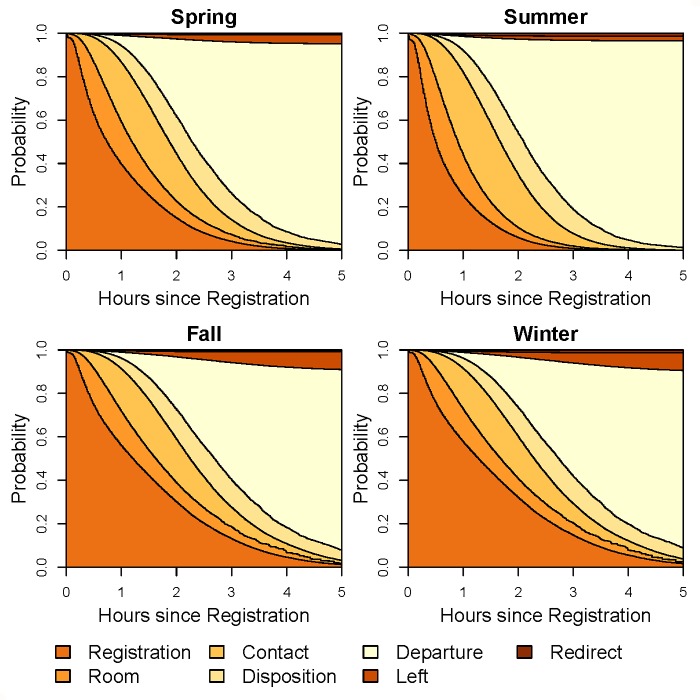
Stacked transition probabilities of the ED multistate model for different seasons.Transition probabilities are conditional on age = 1 year, gender = male, ethnicity = not Hispanic or Latino, race = white, time of the day = 16:00–20:00, ESI = 4, and number of ED physicians = 8.